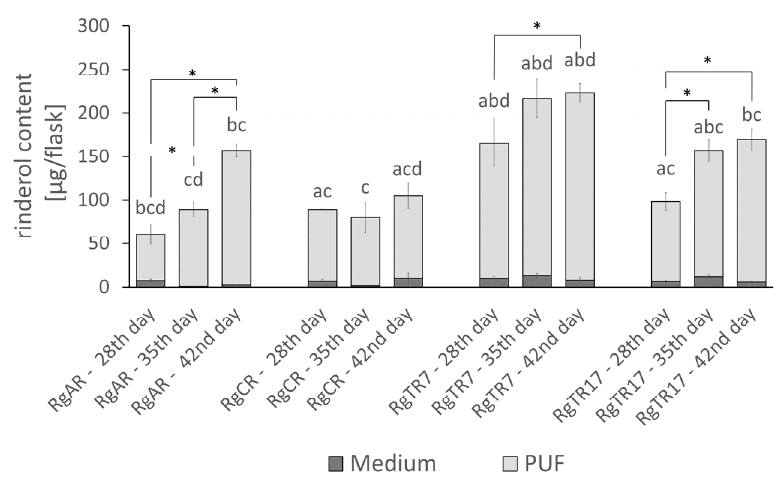
Figure 7. Rinderol productivity [ μ g/flask] in culture systems of R. graeca roots immobilized on PUF. Rinderol was detected only in post ‐ culture medium and PUF, while it was not present in the root biomass. Presented data are the means ± SD of three independent replicates. Asterisks (*) above square brackets indicate statistically significant differences ( p ≤ 0.05) in rinderol productivity between consecutive time points within each root line. Letters indicate statistically significant differences ( p ≤ 0.05) in rinderol productivity between root lines: RgAR (a), RgCR (b), RgTR7 (c), and RgTR17 (d) at respective time points.